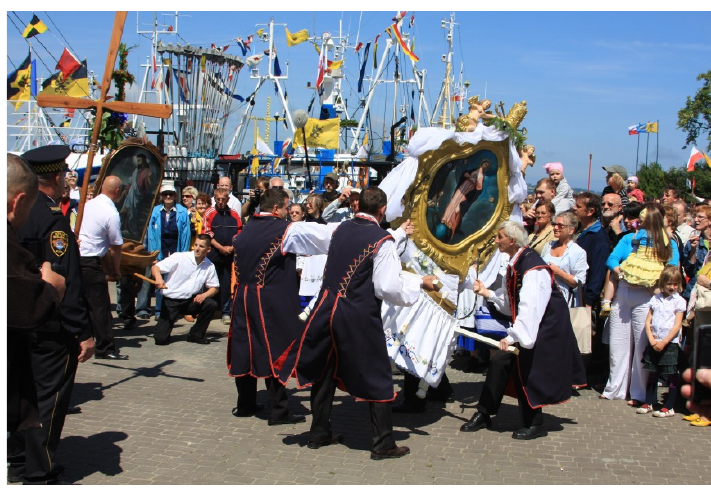
Figure 6. The feretron dance in Puck. Author: (Tadeusz Palmowski 2009). After the welcoming feretron dance, delegations with feretrons and church banners, the banners of the Kashubian–Pomeranian Association divisions from the whole Pomerania region, the Polish Sea Fishermen’s Association banner, as well as other flags, position themselves on both sides of the field altar, placed between the church and the port. On the right side, facing the altar, there are the choir and the orchestra, whose members orig-